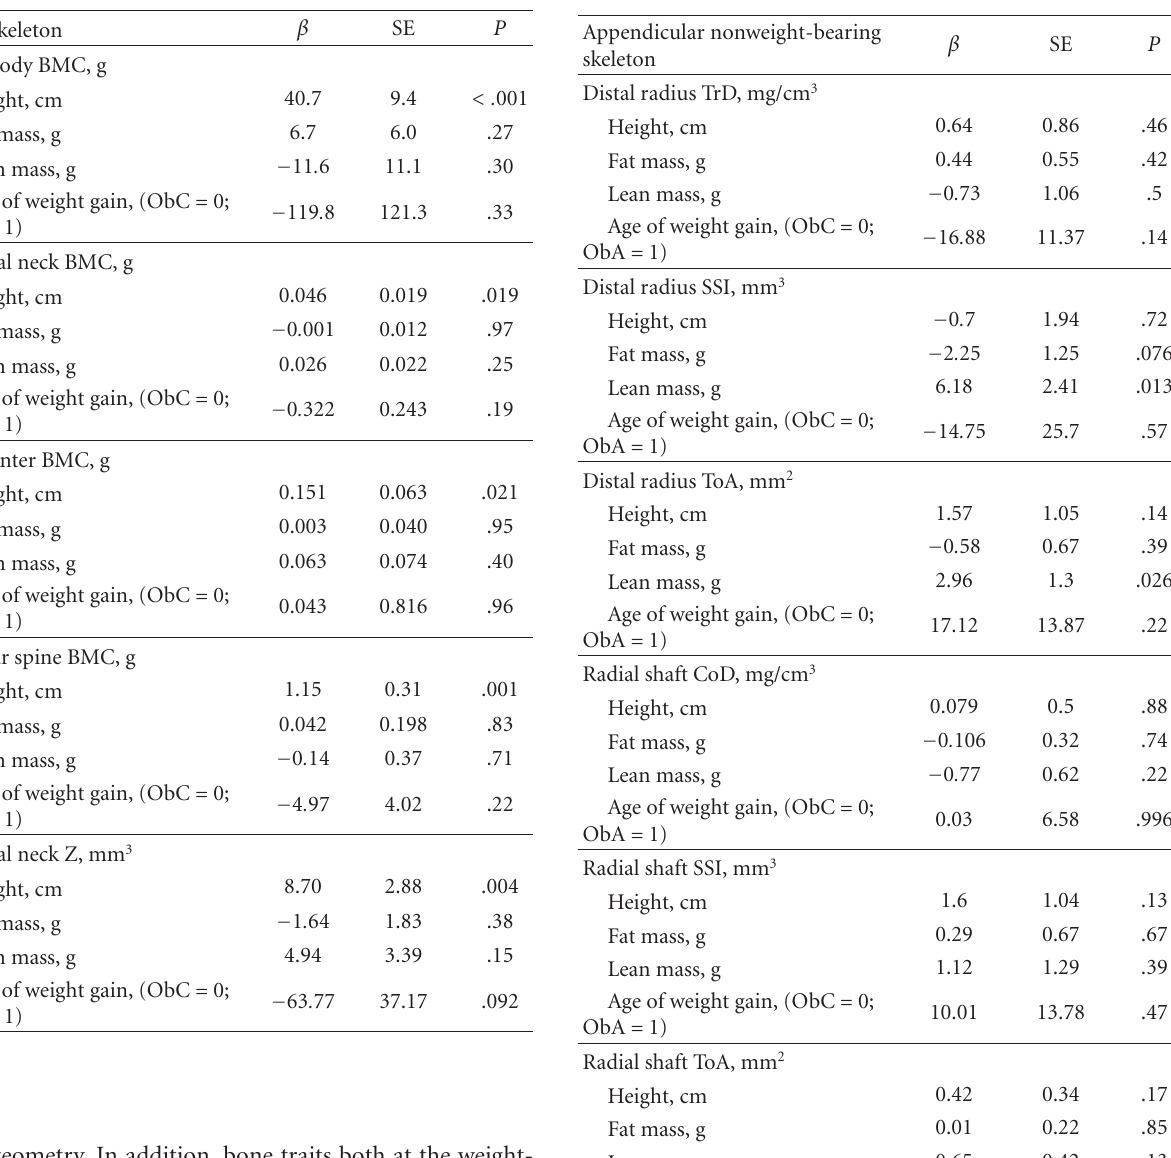
Table 3: Multiple linear regressions showing the simultaneous e ff ects of height, lean, and fat mass and age of weight gain on bone traits in the axial skeleton.